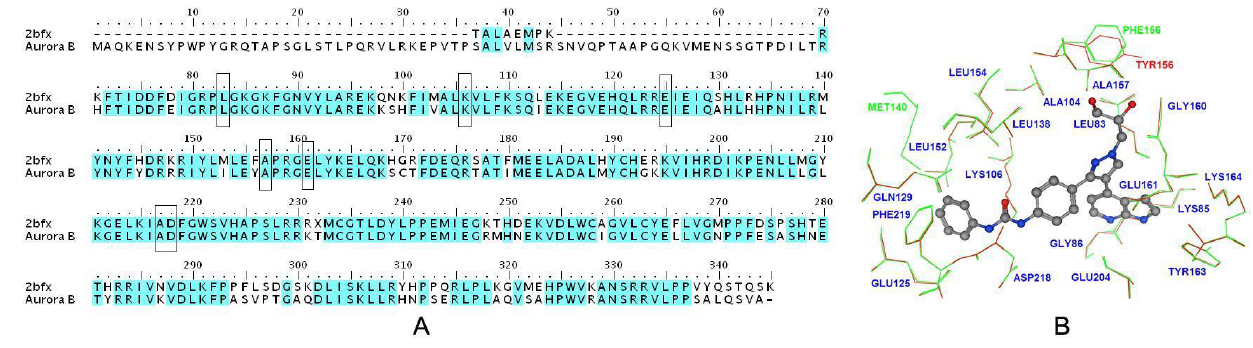
Figure 2. ( A ) The alignments of the sequences of 2BFX chain A template and Aurora B target protein. The identical amino acid residues in the sequence alignment are highlighted in cyan. Dashed lines denote the amino acid residues deletion. The key residues of binding site are highlighted in black rectangles; ( B ) The enlargement of the superposition structure of the active site with compound 40 displayed in sticks. The residues from the template protein and the homology modeling protein are highlighted in green and red colors respectively, the same residues in the active site are labeled in blue color, while the residues differing between them are labeled in their own